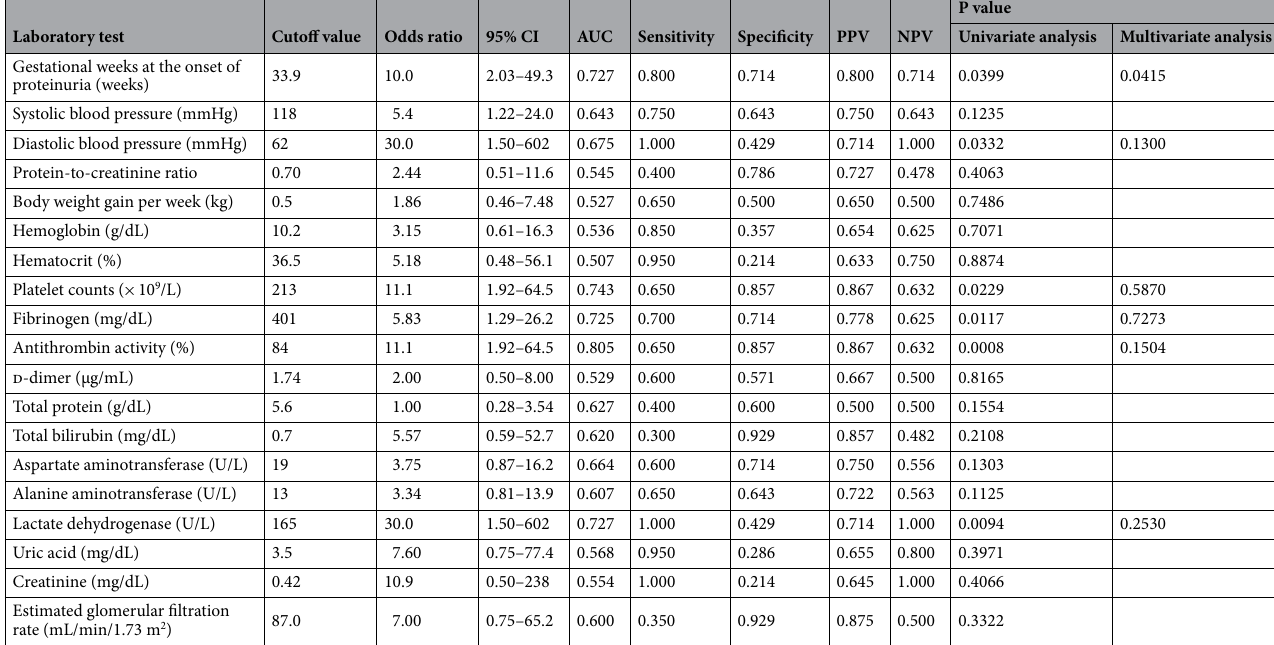
Table 2. Relationship between laboratory cutoff values and progress from presumptive gestational proteinuria to preeclampsia. Laboratory findings were based on the receiver operating characteristic curve. CI confidence interval, AUC area under the curve, PPV positive predictive value, NPV negative predictive value.